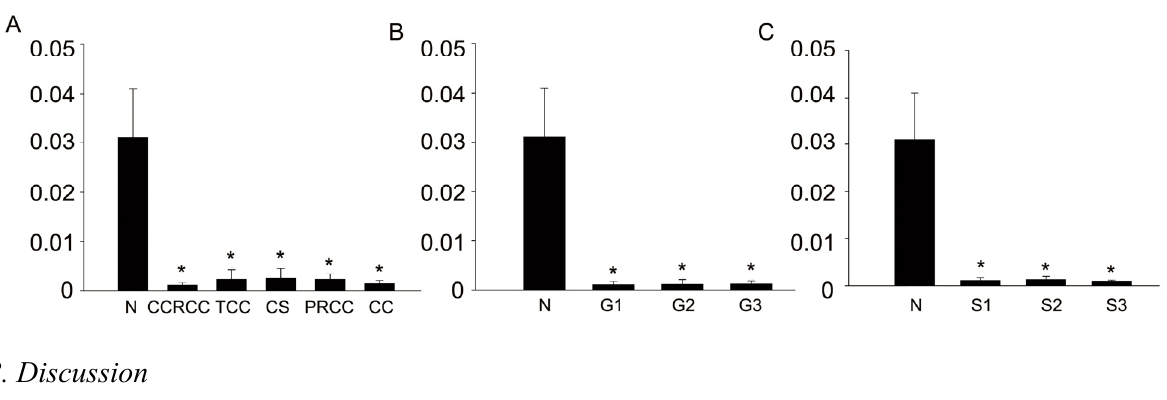
Figure 7. Semi-quantitative analysis of nonEN2 IHC in renal cell carcinoma. ( A ) Normal kidney tissue (N), clear cell renal carcinoma (CCRCC), kidney transitional cell carcinoma (TCC), carcinoma sarcomatodes (CS), papillary renal cell carcinoma (PRCC) and chromophobe carcinoma (CC); ( B ) Normal tissues (N), Grade 1 (G1), Grade 2 (G2) and Grade (G3) in CCRCC; and ( C ) Normal tissues (N), Grade 1 (S1), Grade 2 (S2) and Grade (S3) in CCRCC. * represents p < 0.05 when compared with the normal kidney